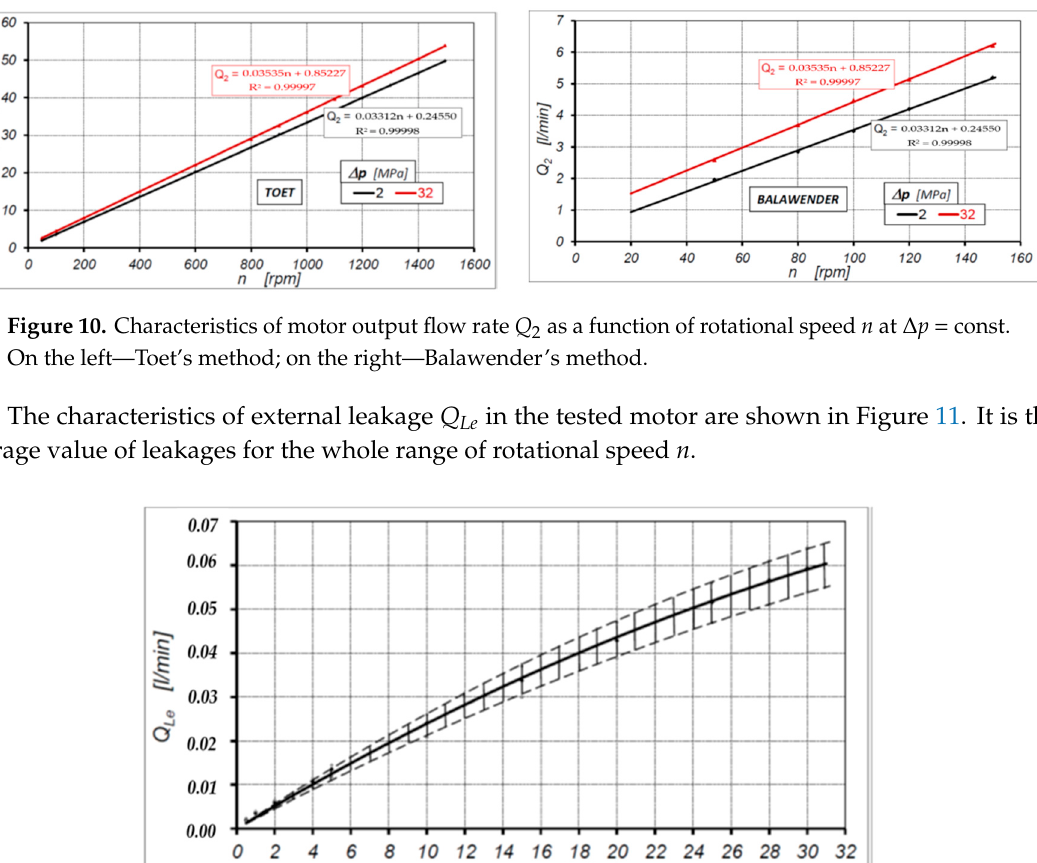
Figure 12. Characteristics of motor output flow rate Q 2 vs. rotational speed n at Δ p i = const. The influence of liquid compressibility is omitted. The results of the flow rate measurements Q 2 (Figure 10) were corrected for the difference resulting from the compression of the oil to the supply pressure p 1 —according to Formula (40) (Toet’s method) and Formula (42) (Balawender’s method). The characteristics presented in Figure 13 were